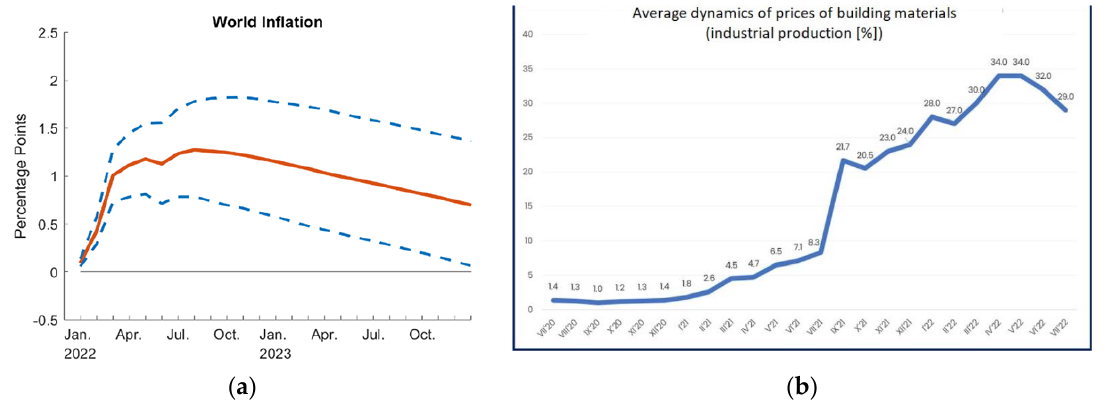
Figure 1. Inflation level and average growth rate of building materials prices. ( a ) Inflation in the world after 2019 [24]. ( b ) Increase in prices of building materials after 2019 [32].